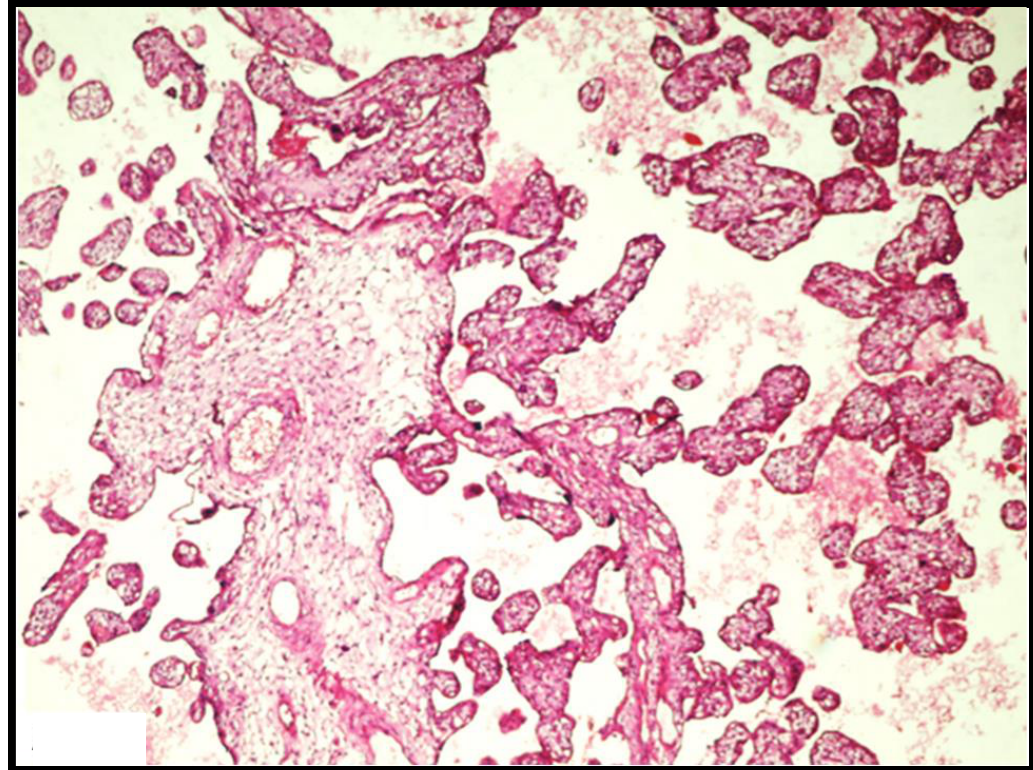
Figure 1: Placental mesenchymal dysplasia showing a mixture of normal (right side) and dilated (left side) chorionic villi (X